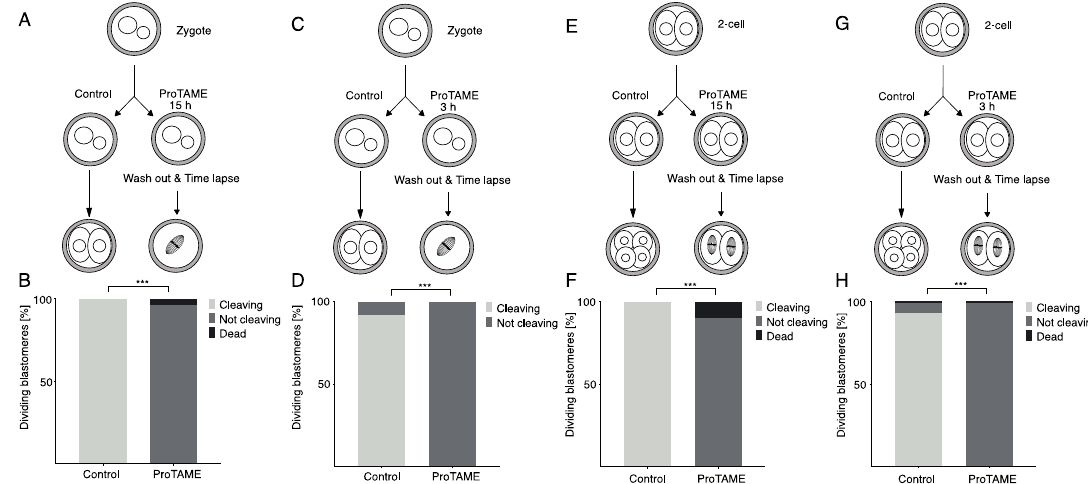
Figure 5. ProTAME-induced arrest in mouse embryos is irreversible. ( A ) Zygotes isolated 18–21 h post hCG stimulation were divided into two groups: the control group and proTAME-treated group. ProTAME-treated zygotes were exposed to the inhibitor for 15 h and washed out, and their development was monitored by live cell microscopy. ( B ) The frequency of developing zygotes in the control group ( n = 68) and in the group after 20 µ M proTAME treatment ( n = 80). A total of 100% of control zygotes and 0% of zygotes after 20 µ M proTAME treatment developed to the two-cell stage, and 4% zygotes after 20 µ M proTAME treatment were dead. Data were obtained in two independent experiments. The di ff erence between the control group and proTAME is statistically significant ( α < 0.05; *** p < 0.001). ( C ) Zygotes isolated 21 h post hCG stimulation and 26 h post hCG were divided into two groups: the control group and proTAME-treated group. ProTAME-treated zygotes were exposed to the inhibitor for 3 h and washed out, and their development was monitored by live cell microscopy. ( D ) The frequency of developing zygotes in the control group ( n = 25) and in the group after 20 µ M proTAME treatment ( n = 25). A total of 92% of control zygotes and 0% of zygotes after 20 µ M proTAME treatment developed to the two-cell stage. The di ff erence between the control group and proTAME is statistically significant ( α < 0.05; *** p < 0.001). Presented are results from a single experiment. ( E ) Two-cell embryos isolated 41 h post hCG stimulation and 48 h post hCG cells were divided into two groups: the control group and proTAME-treated group. ProTAME-treated embryos were exposed to the inhibitor for 15 h and washed out, and development was monitored by live cell microscopy. ( F ) The frequency of dividing two-cell blastomeres in the control group ( n = 173) and in the group after 20 µ M proTAME treatment ( n = 158). A total of 100% of control blastomeres were cleaving and 0% of blastomeres after 20 µ M proTAME treatment were cleaving; 10% of blastomeres after 20 µ M proTAME treatment were dead. The di ff erence between the control group and proTAME is statistically significant ( α < 0.05; *** p < 0.001). Data were obtained in two independent experiments. ( G ) Two-cell embryos isolated 41 h post hCG stimulation and 50 h post hCG cells were divided into two groups: the control group and proTAME-treated group. ProTAME-treated embryos were exposed to the inhibitor for 3 h and washed out, and development was monitored by live cell microscopy. ( H ) The frequency of dividing two-cell blastomeres in the control group ( n = 100) and in the group after 20 µ M proTAME treatment ( n = 100). A total of 93% of control blastomeres and 0% of blastomeres after 20 µ M proTAME treatment were cleaving, while 1% of blastomeres in each group were dead. The di ff erence between the control group and proTAME is statistically significant ( α < 0.05; *** p < 0.001). Data were obtained in two independent experiments.